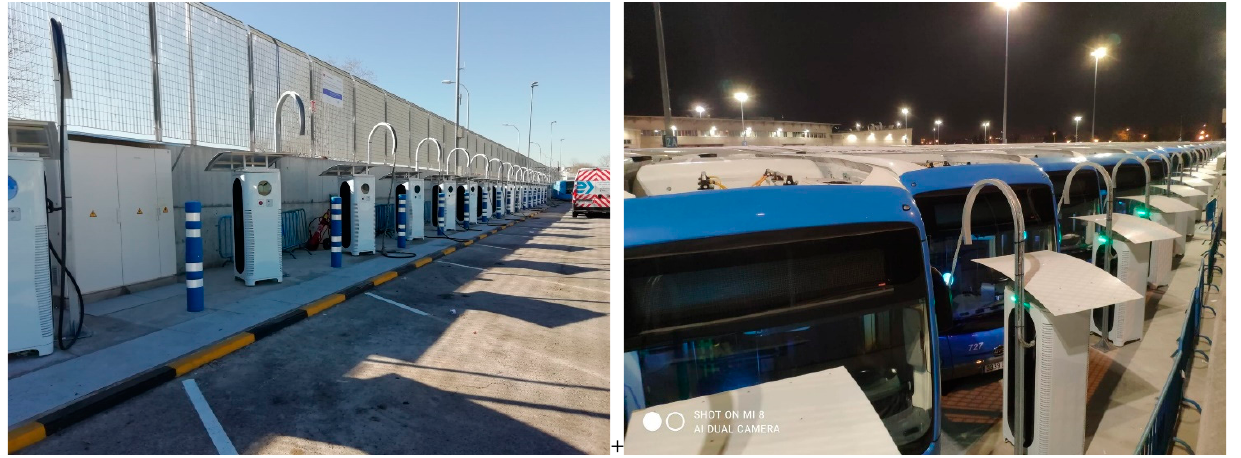
+ Figure 4. Pictures of wired charging in Carabanchel OC (Madrid), funded by FEDER funds, EU.